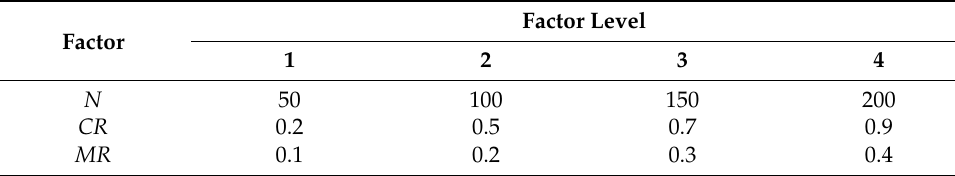
Table 1. Factor level setting of MHSSA parameters.